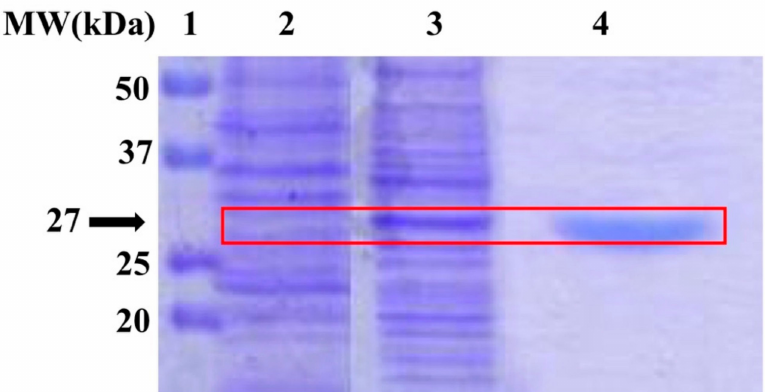
Figure 1. SDS-PAGE analysis. The overexpression of the MreCA fusion protein was obtained using 1 mM IPTG. The overexpressed fungal CA is well evident in lane 2 at the molecular weight of 27 kDa, while it was absent in lane 1, which contained the cell lysate supernatant before IPTG induction. After induction, the soluble MreCA was passed through the HisTrap FF column to obtain a highly pure and homogenous MreCA. Legend: Lane 1, molecular markers; Lane 2, cell lysate supernatant; Lane 3, IPTG induction; Lane 4, purified MreCA. The red box identifies the height in the gel corresponding to 27